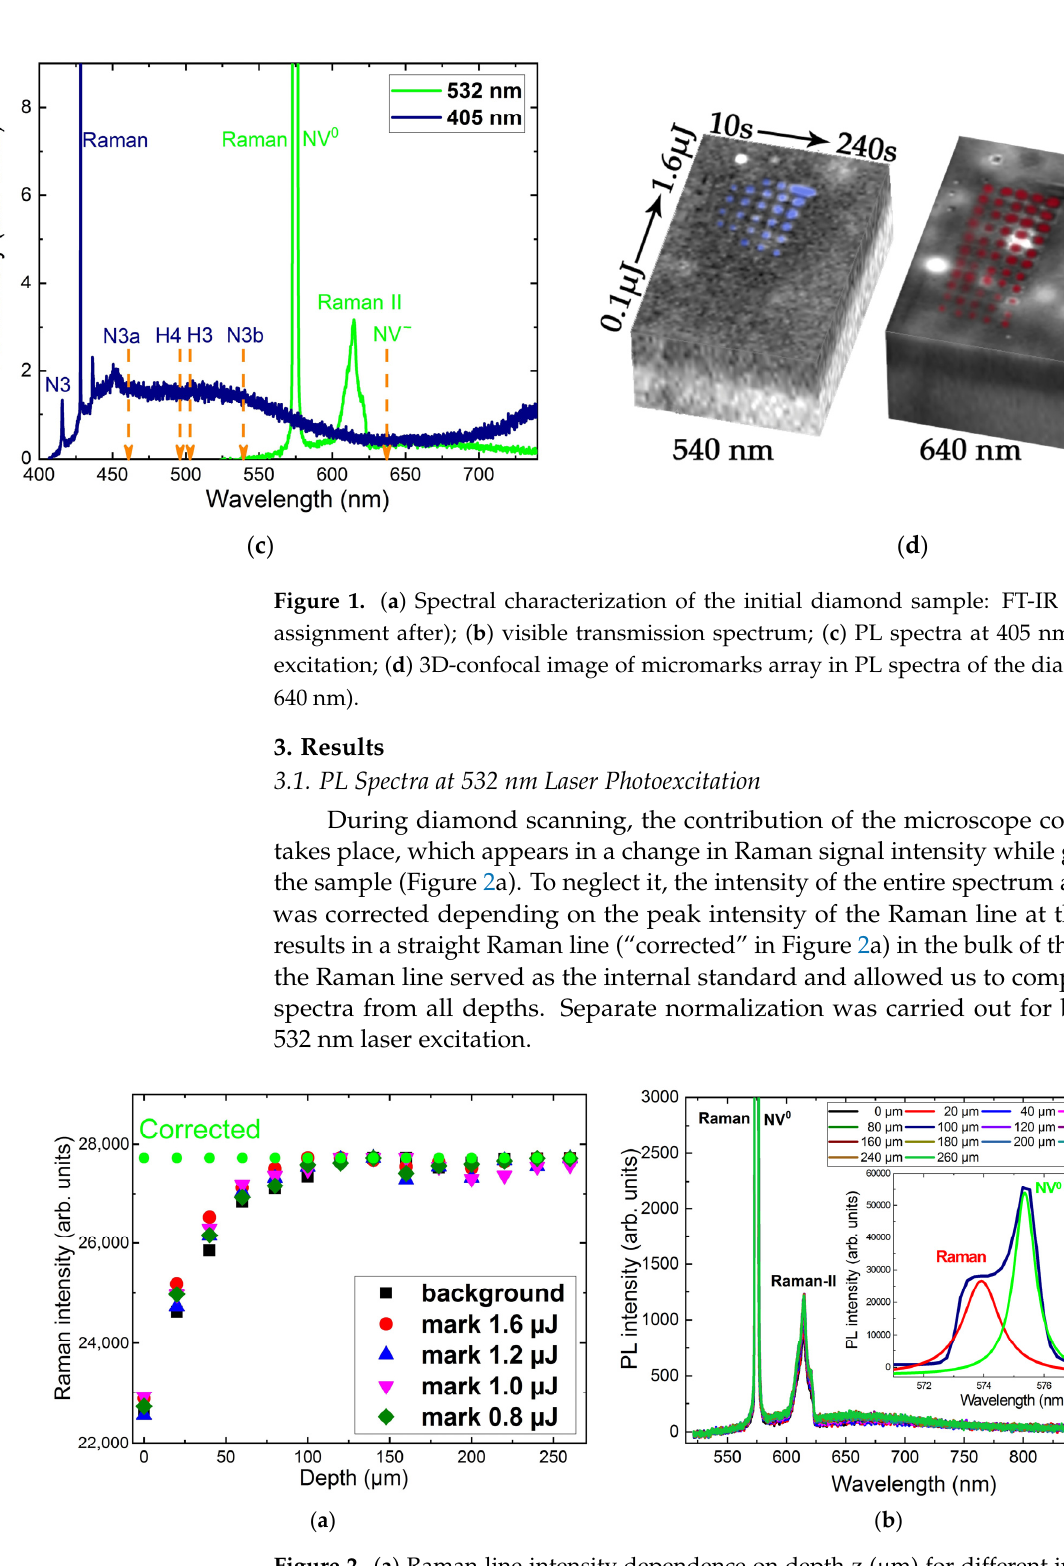
Figure 2. ( a ) Raman line intensity dependence on depth z (µm) for different incident 0.3 ps laser pulse energies (µJ); ( b ) 532 nm excitation PL spectra of unexposed diamond at different depths inside the sample.